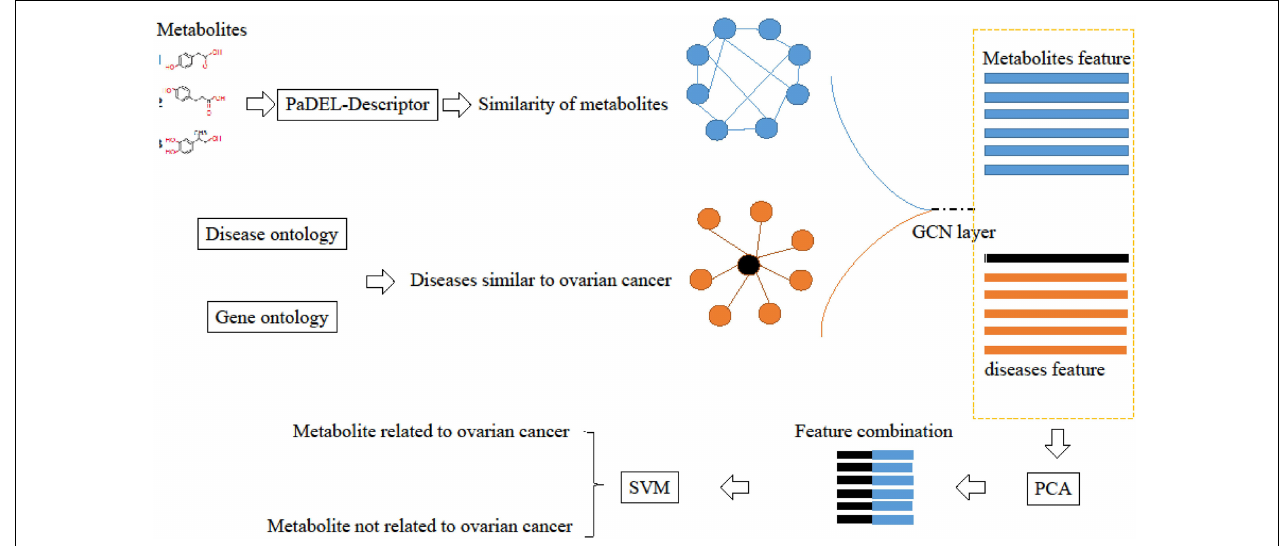
FIGURE 1 | Workflow of GPS-OCM (the fusion of GCN, PCA, and SVM to identify ovarian cancer-related